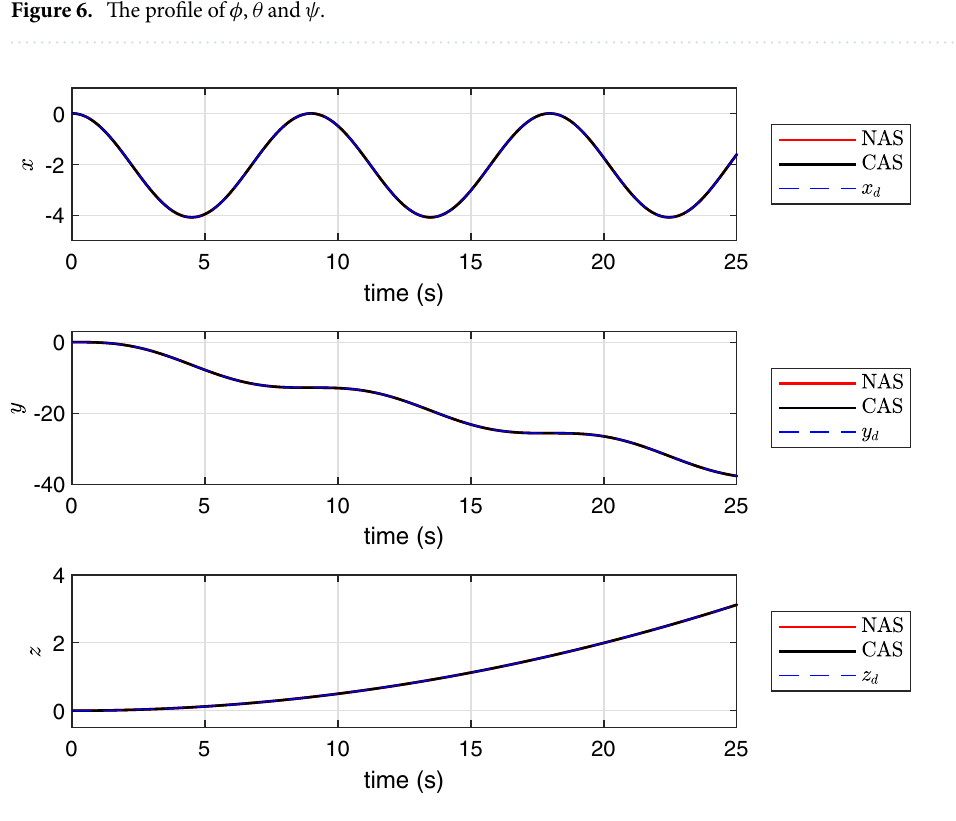
Figure 7. The profile of x , y and z